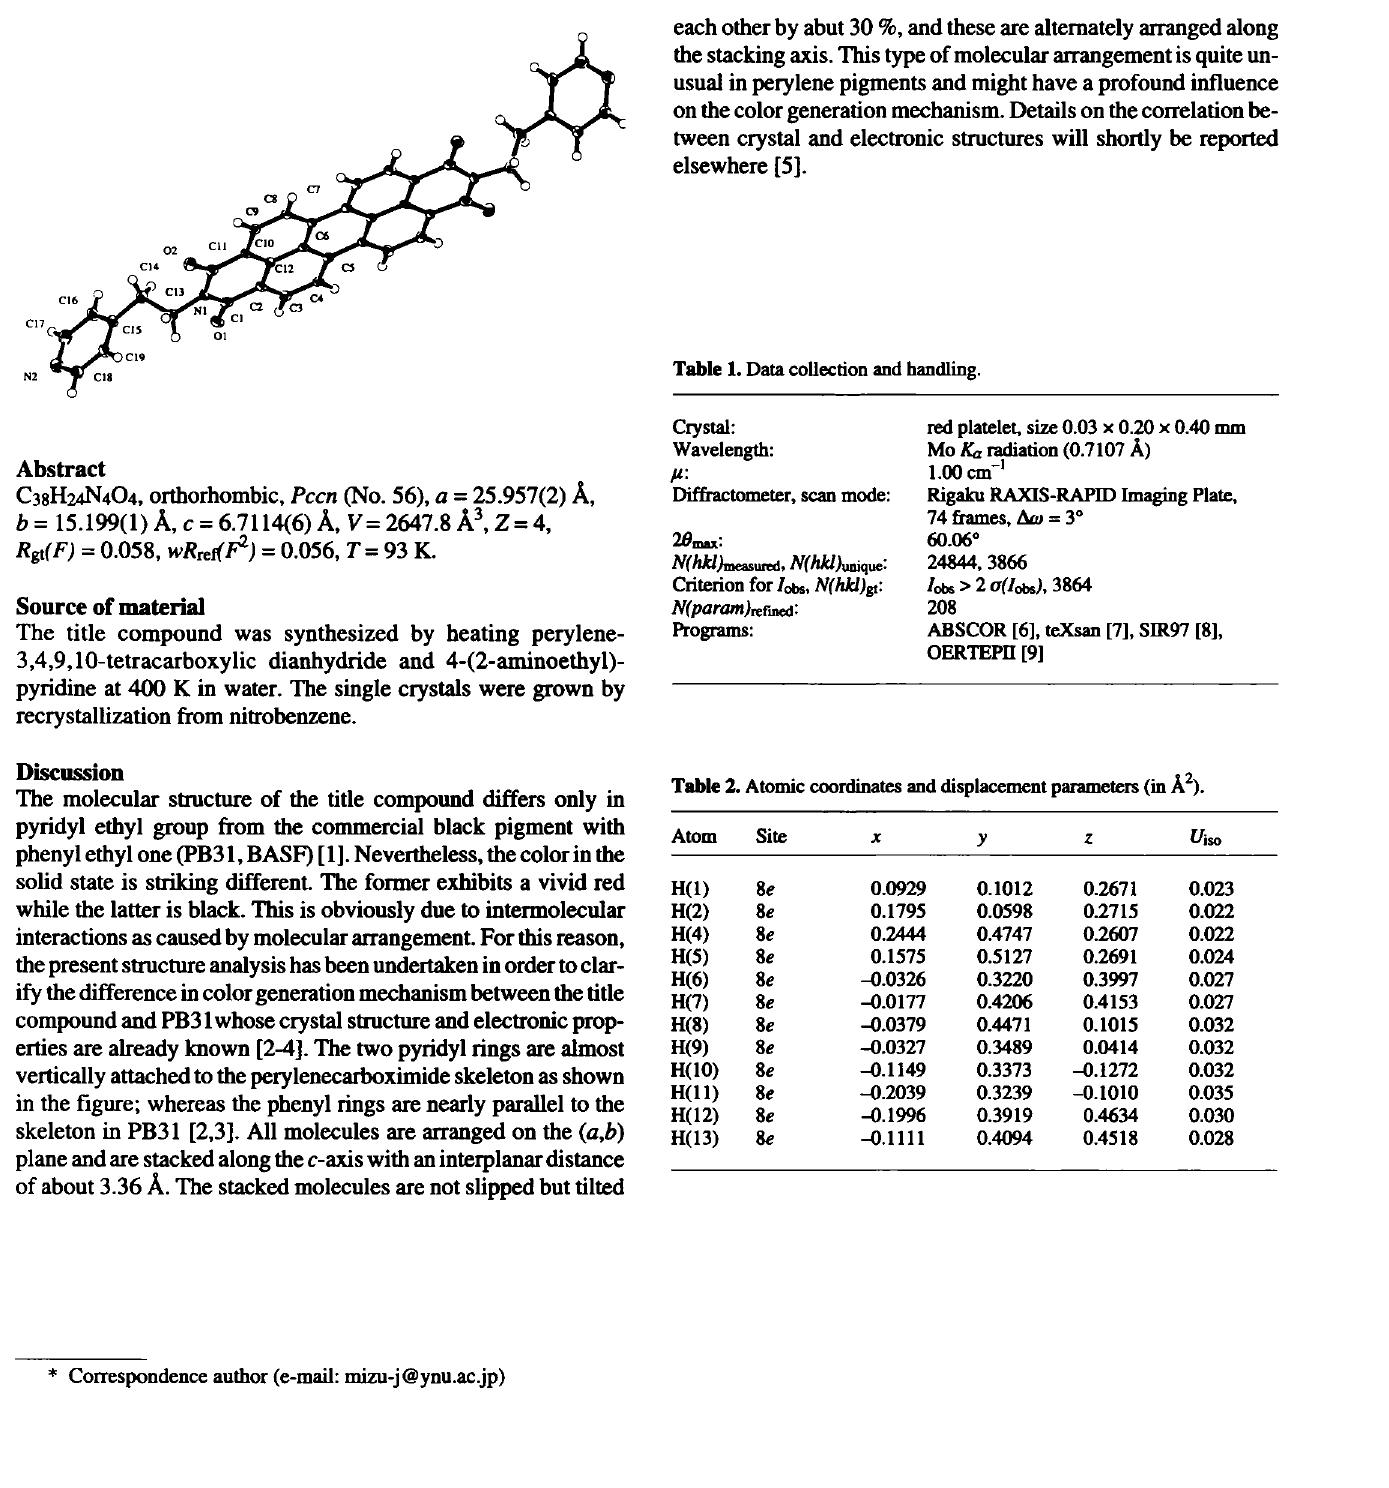
Table 1. Data collection and handling.